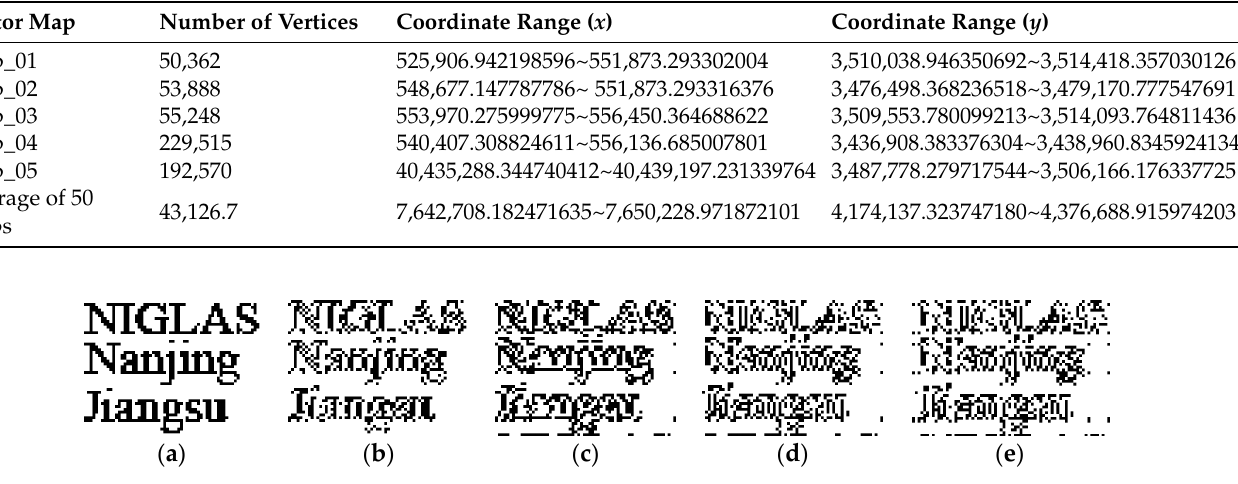
Figure 10. Results of error-correcting coding and checking coding: ( a ) is the original copyright watermark image with a size of 64 × 48 (unit: pixel), ( b ) is the 1st stage of ECC with a size of 64 × 48 (unit: pixel), ( c ) is the 2nd stage of ECC with a size of 64 × 48 (unit: pixel), ( d ) is the XOR code of ( b , c ) whose size is also 64 × 48 (unit: pixel) and ( e ) is the Hamming code of ( d ) with a size of 71 × 48 (unit: pixel).